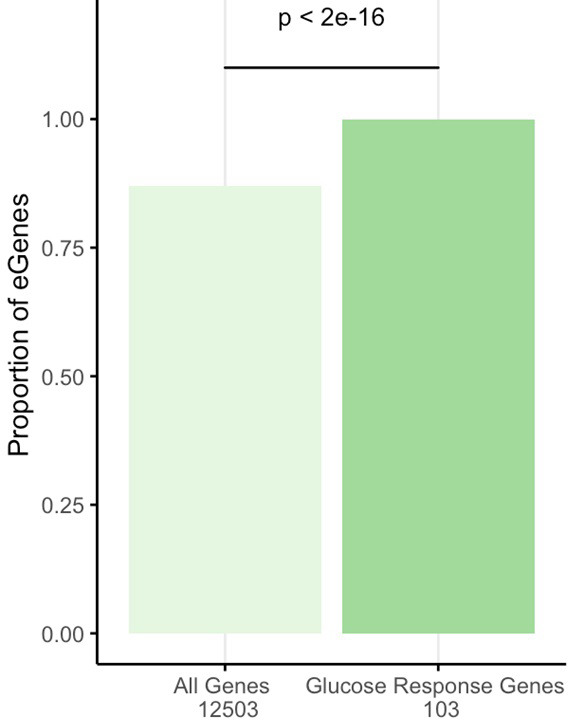
Enrichment of eGenes in glucose differential response genes.The proportion of eGenes is plotted to compare all 12,503 genes assessed on the microarray to the 103 glucose response genes. An eGene is defined as any gene with a GTEx eSNP (q-value <0.05) in any tissue. GTEx (version 7). Source files are available with open access at https://www.gtexportal.org/home/datasets, and code in Source code 9.